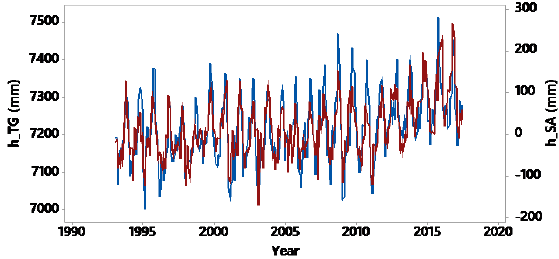
Fig. 1. Overlapping TG (in blue) and SA monthly sea level measure- ments in mm. Each time series refers to its own